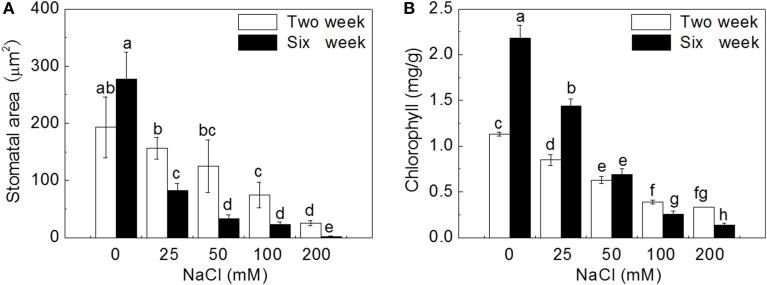
Effects of NaCl treatment on stomatal area (A) and chlorophyll content (B). Values are means and bars indicate SDs (n = 6). Columns with different letters indicate significant difference by Duncan's multiple range tests at P < 0.05.